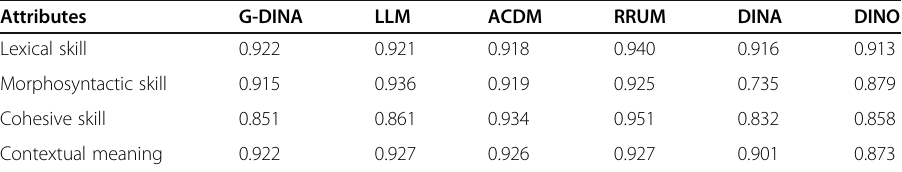
Table 8 Attribute level accuracy Attributes